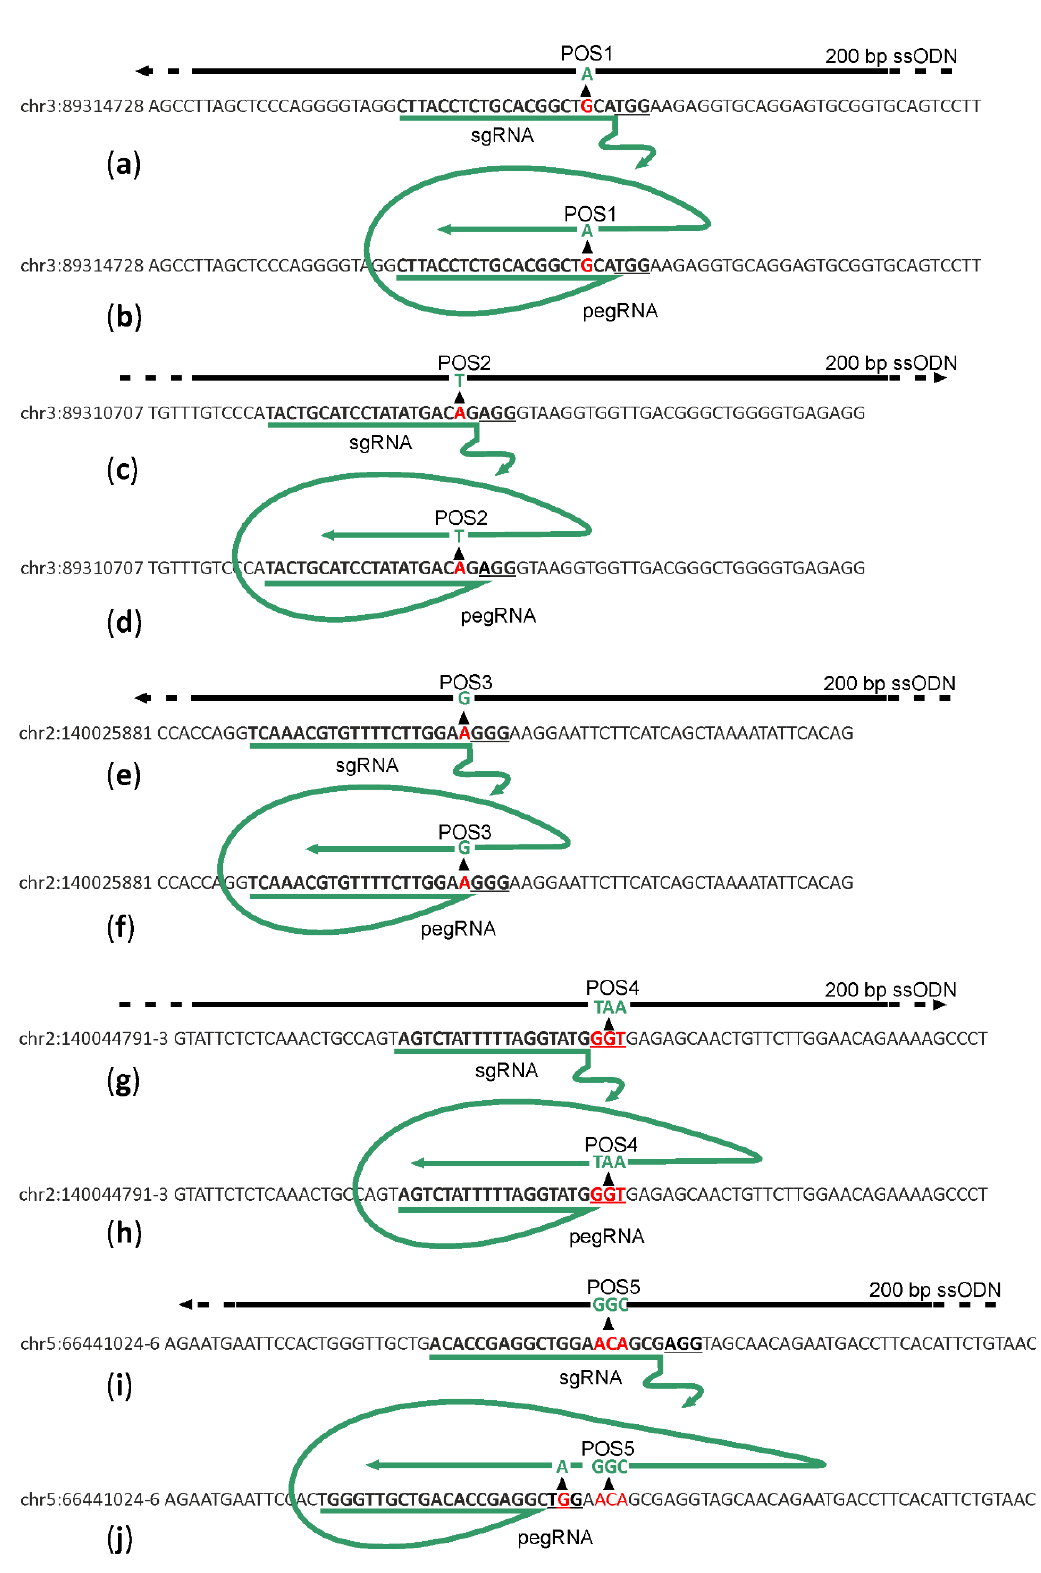
Figure 1. Scheme of sgRNA or pegRNA (green) for target (letters) cleavage and reverse transcription and DNA templates (black lines) for HR. ( a , c , e , g , i ) Schemes for genome regions 1–5 editing by sgRNA directed cleavage and ssDNA directed HR. ( b , d , f , h , j ) Schemes for genome regions 1–5 editing by pegRNA directed cleavage and reverse transcription. PAM sites are underlined. Red and green nucleotides mark the wild type and edited sequences, correspondingly. Editing positions are numbered as POS1–5.